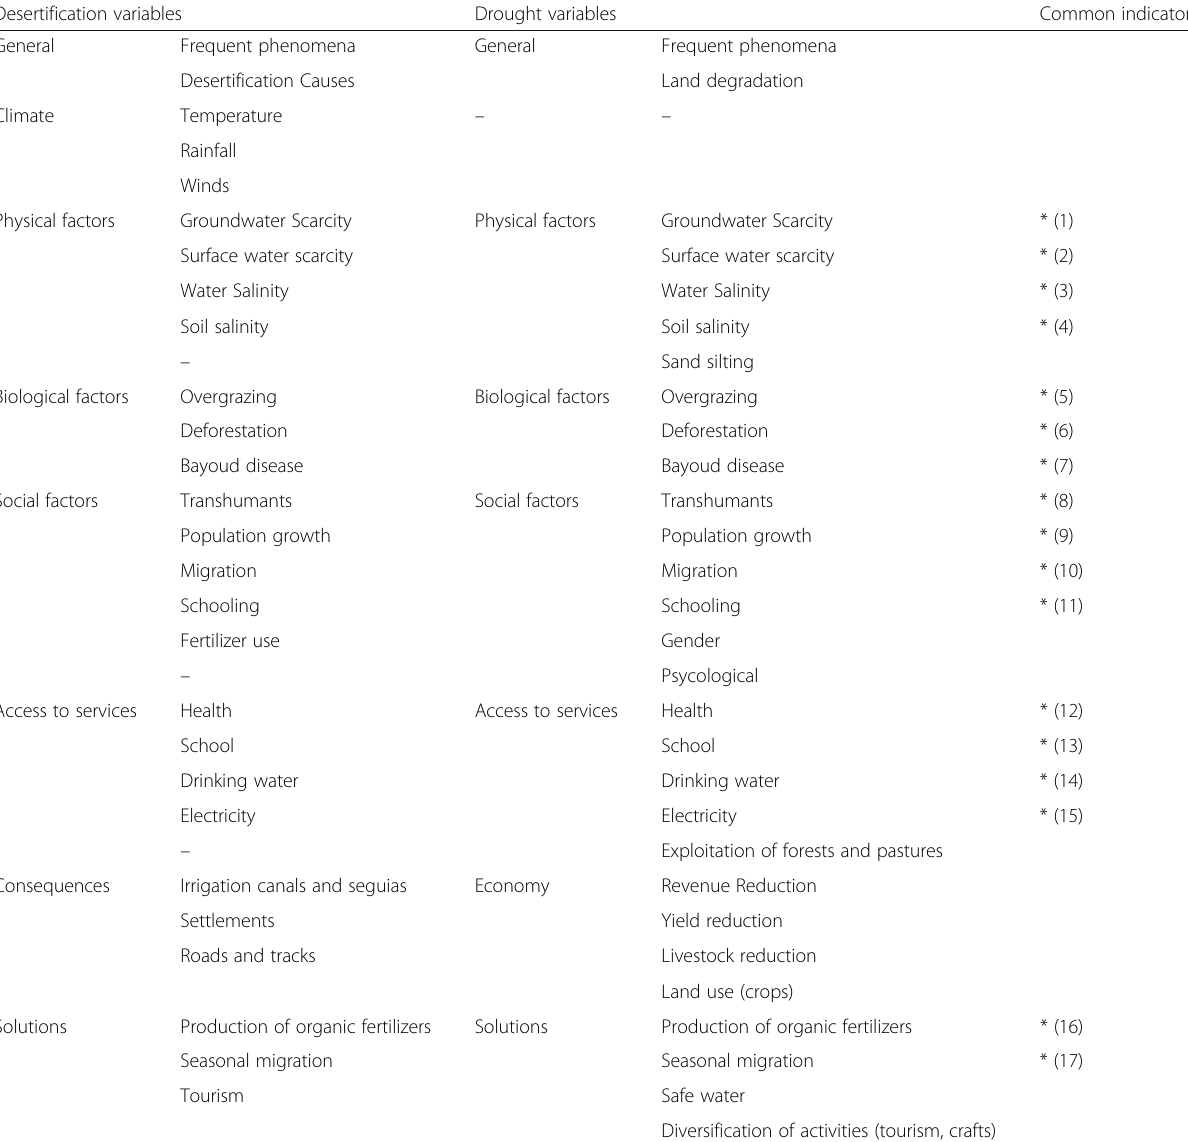
Table 1 The selected variables of drought and desertification in Draa Valley. The last column presents all the variables which are common to the two